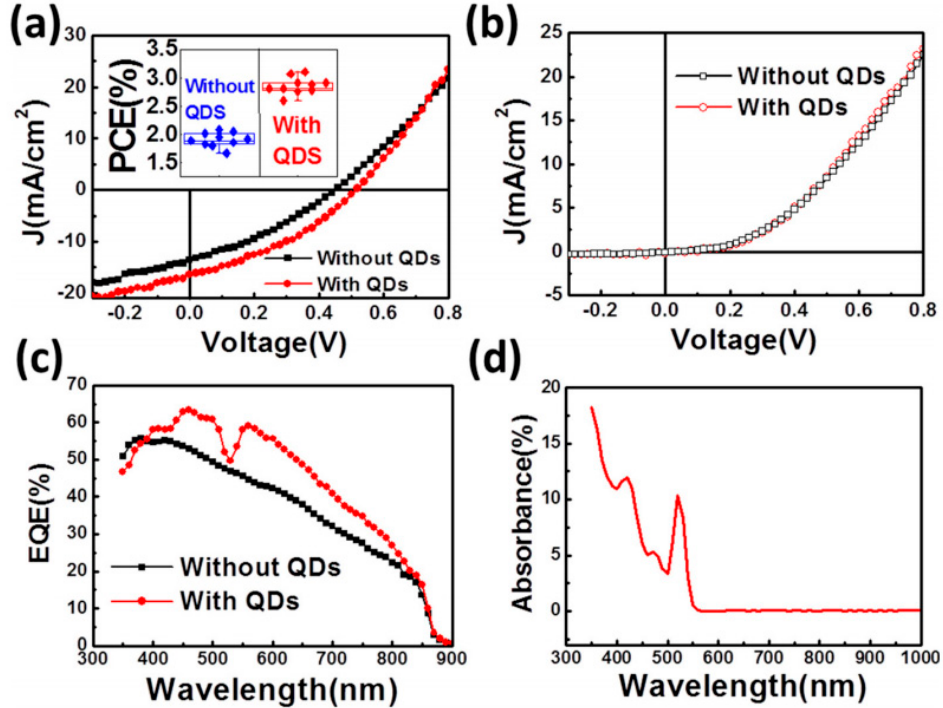
Figure 4. Current density versus voltage (J-V) characteristics of the graphene added devices with and without CdSe QDs under ( a ) AM1.5G illumination and ( b ) dark. The inset of ( a ) shows statistical results of devices with and without QDs. ( c ) External quantum efficiency (EQE) curves of the devices with and without CdSe QDs. ( d ) The absorption spectrum of the CdSe QDs [43].